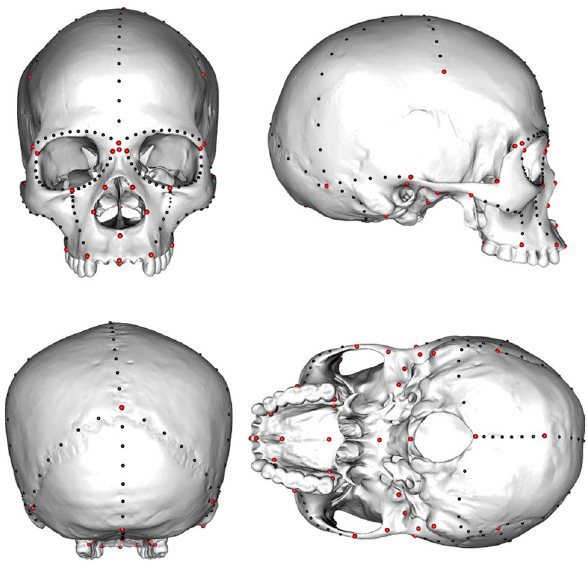
Figure 1. Description of the landmarks (red) and semi-landmarks (black) used in the